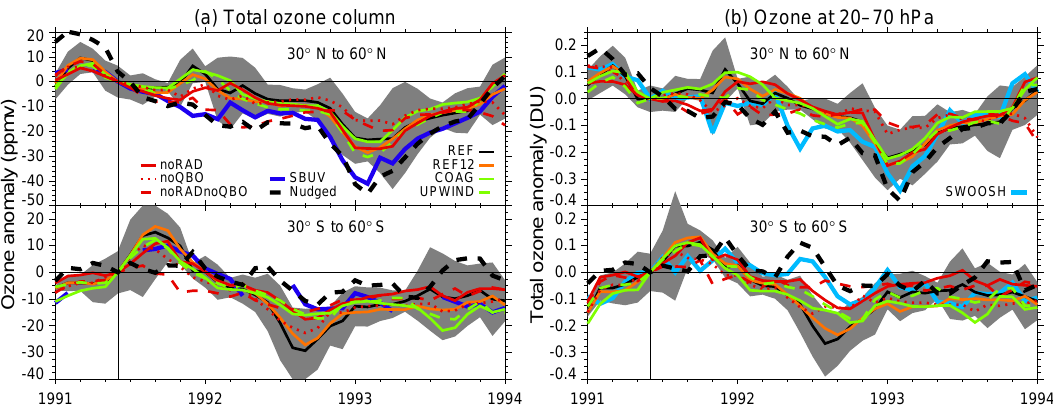
Figure 8. Monthly mean midlatitude (30–60 ◦ north and south) ozone anomalies from SOCOL-AER compared with observations. (a) Total ozone column. (b) Ozone mixing ratio at 20–70hPa. Observational data sets SWOOSH and SBUVv8.6 are denoted by light and dark blue lines, respectively. Anomalies are computed by subtracting the annual cycle. Grey shaded area: 2 σ ensemble spread of the REF experiment. All other experiments are shown as ensemble